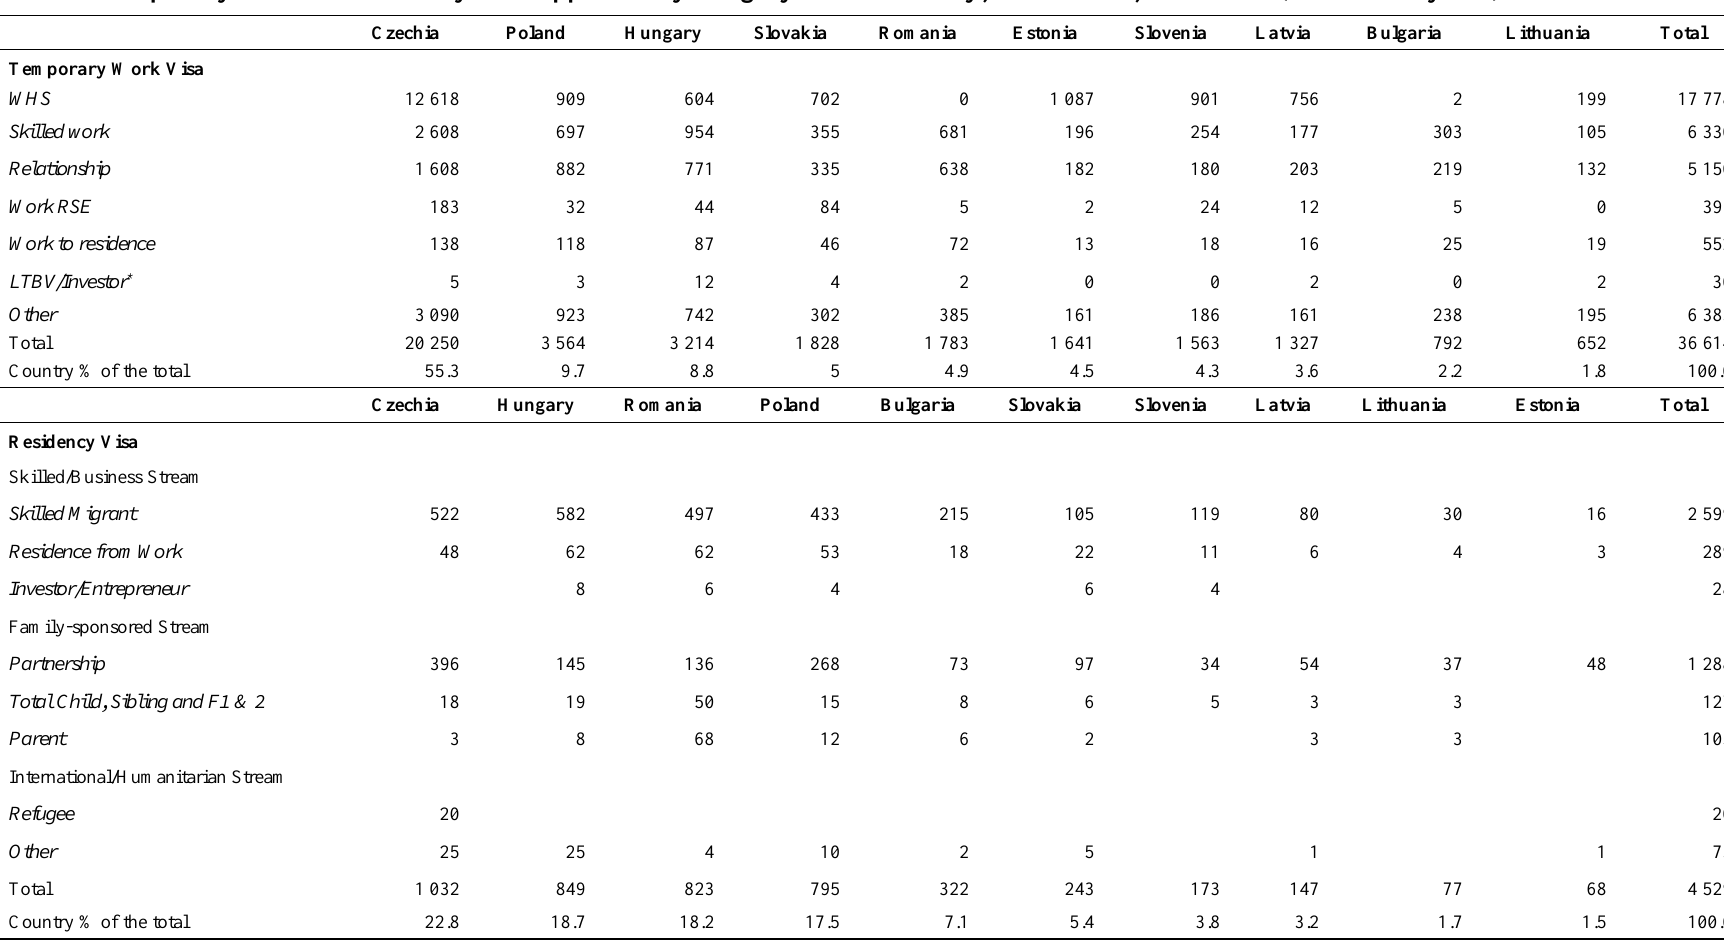
Table 4. Temporary work and residency visas approved by category and nationality, CEE EU-10, 2008–2018 (end of June years) in